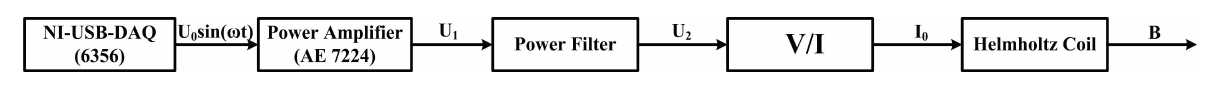
Figure 2. Signal transmission path of the magnetic field excitation